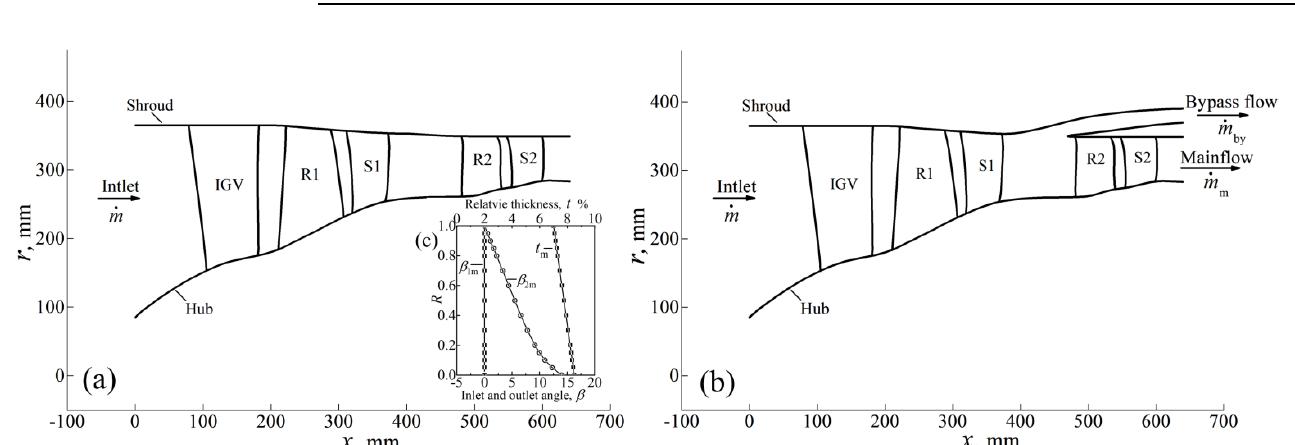
Table 2. Bypass mass-flow ratio (cid:1865)̇ (cid:2912)(cid:2935) (cid:1865)̇⁄ at different rotating speeds.